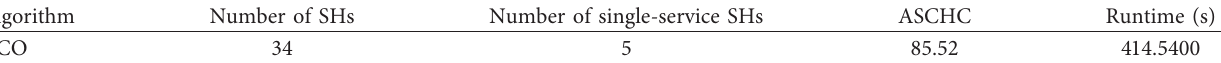
Table 2: Summary of SH results.